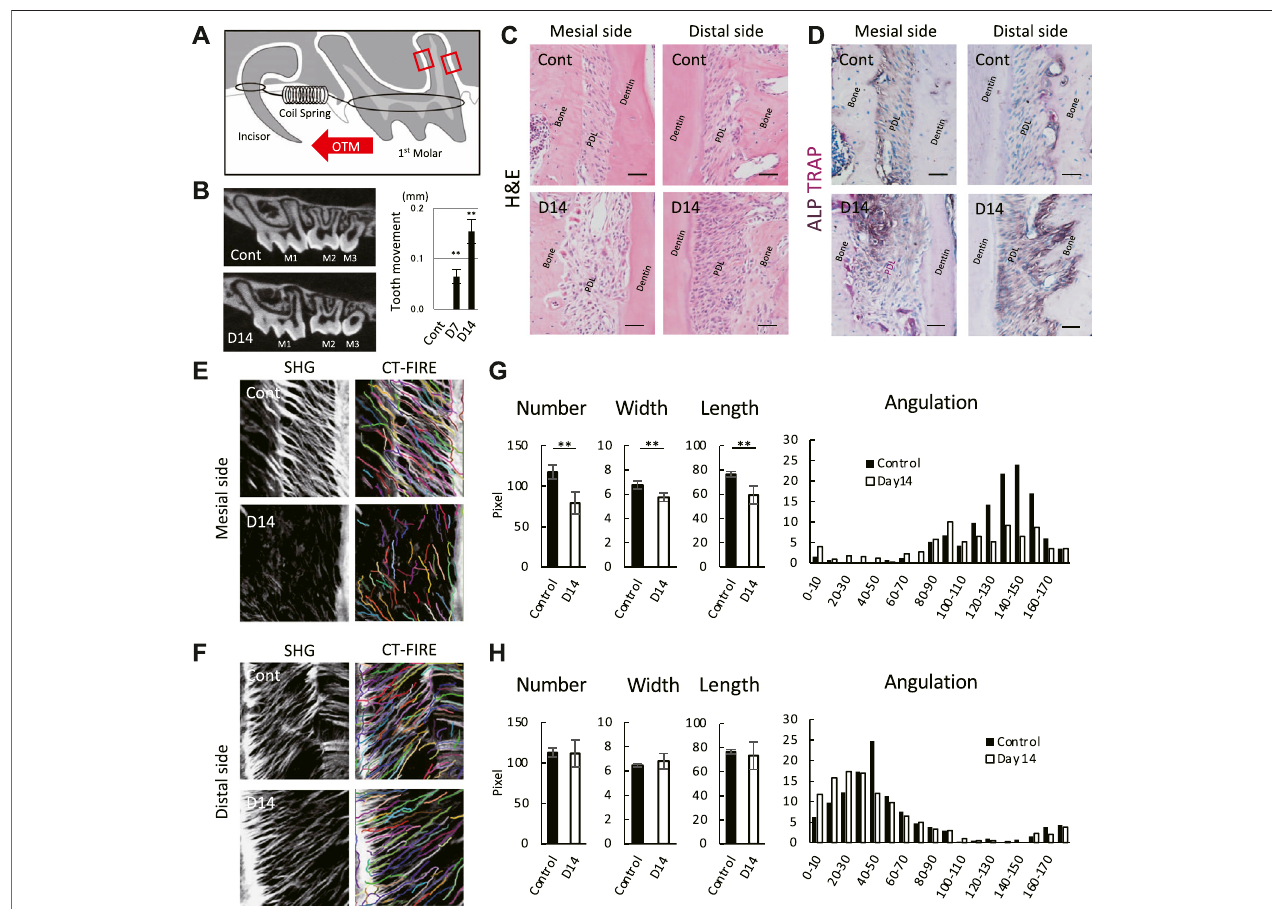
FIGURE1| Mousemolarorthodontictoothmovement(OTM)andmacroscalecharacteristicsofcollagenous fi bersinthePDL. (A) SchematicoftheOTM.Regionof interests are indicated by red rectangles. (B) Representative micro-CT images of controls (Cont) and at day 14 (D14) of the OTM. The distance between the proximal surfaces of the 1 st and 2 nd molar. ** p < 0.01 ( n = 8, mean ± SD) (C,D) Staining at the mesial and distal sides of the PDL by hematoxylin and eosin (H,E) ( n = 3) (C) and TRAP/ALP ( n =3) (D) .Scale bar:50 μ m (E,F) SHG microscopy image andcollagenous fi bers atthemesial (E) and distal (F) sidesofthePDL.Individual fi bers were detected using CT-FIRE. Quanti fi cation of detected fi bers at the mesial (G) and distal (H) sides of the PDL. ** p < 0.01 ( n = 3, mean ±